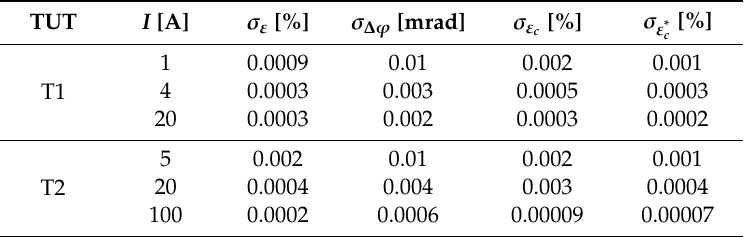
Table 8. σ ε , σ ∆ ϕ , σ ε and σ ε ∗ are the maximum standard deviations of the averages of ε , ∆ ϕ , ε c and ε ∗ c , c c respectively, for both the TUTs at 0.05 I pr , 0.2 I pr and I pr